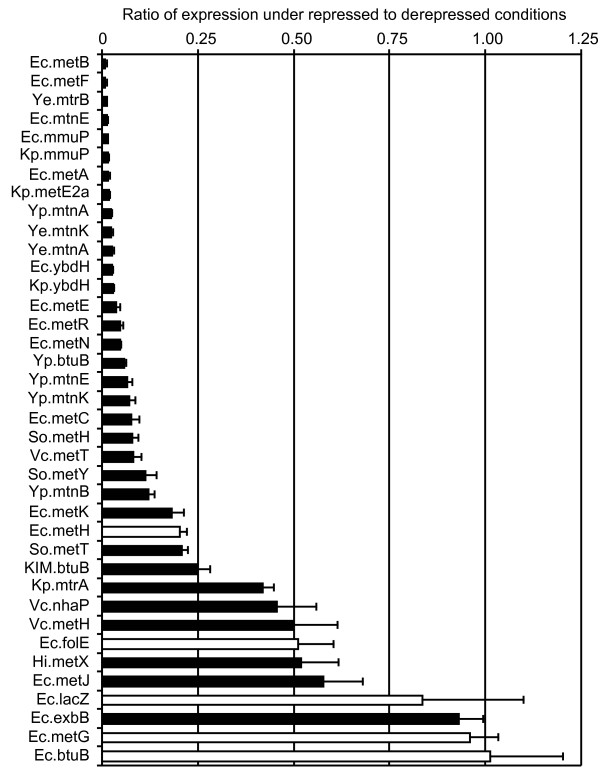
ONPG assay for testing regulation in vivo. The results of the ONPG assay are summarized as the ratio of expression under repressed conditions (wt E. coli) to that under derepressed conditions (ΔmetJ). Black bars indicate the operator sequence was bound by MetJ in a gel-shift assay (Figure S1), while white bars were not bound. Species abbreviations are: Ec, Escherichia coli K12 W3110; Hi, Haemophilus influenzae Rd KW20; KIM, Yersinia pestis KIM; Kp, Klebsiella pneumoniae; So, Shewanella oneidensis; Vc, Vibrio cholerae N16961; Ye, Yersinia enterocolitica; Yp, Yersinia pseudotuberculosis YPIII.